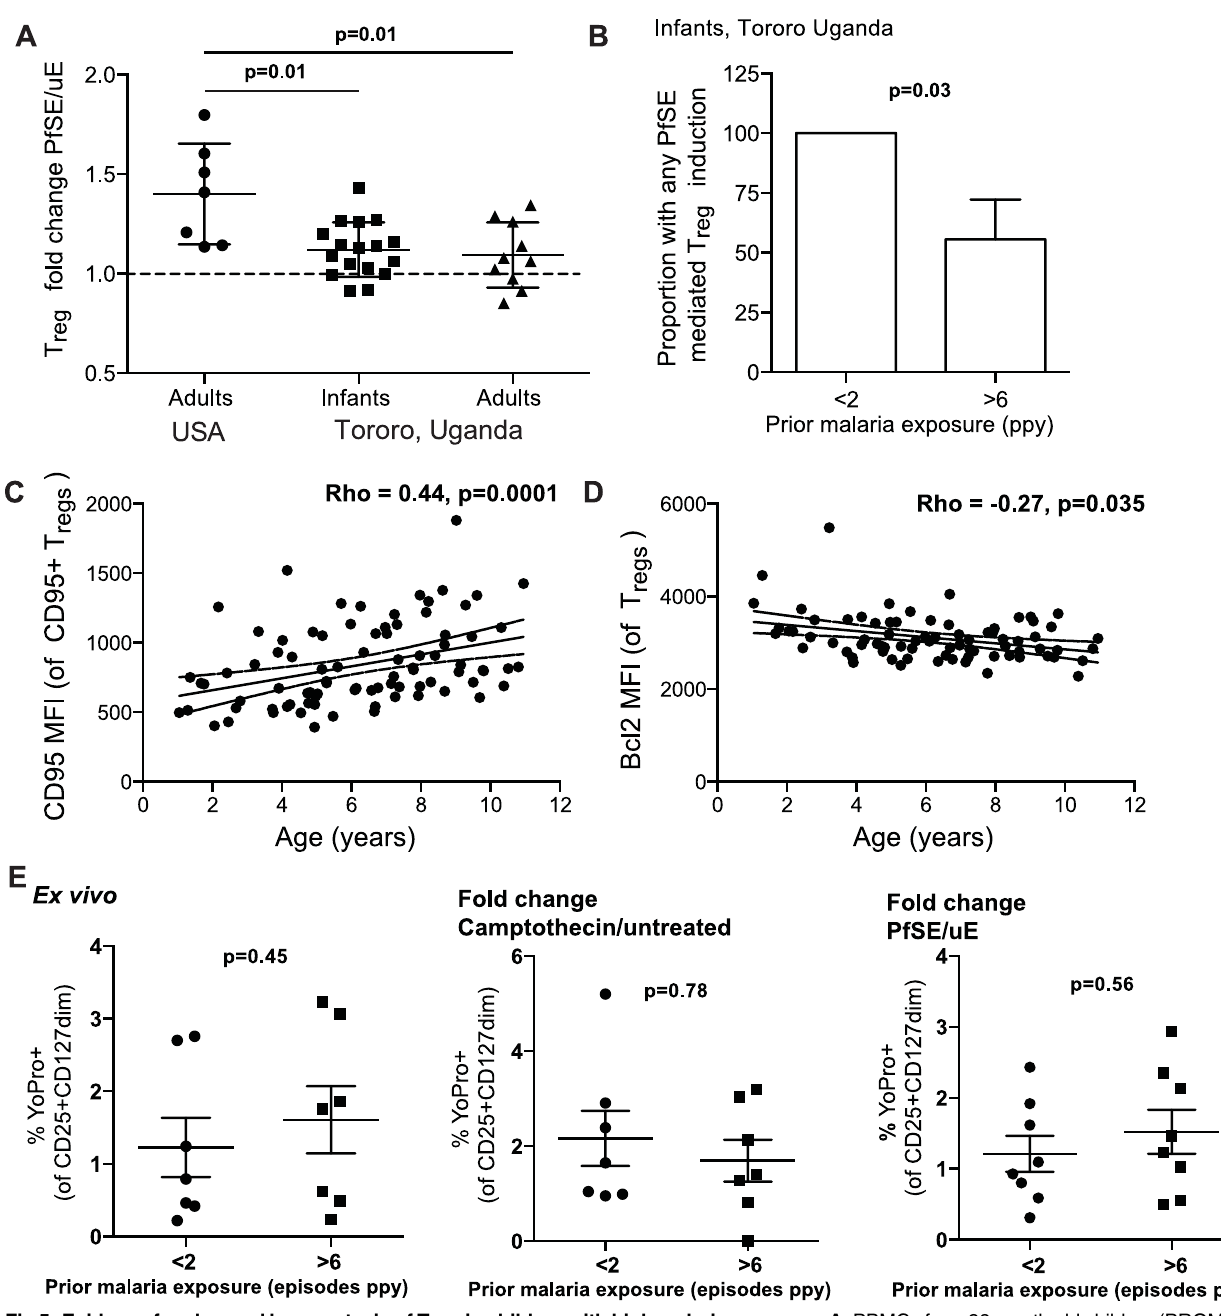
Fig 5. Evidence for changed homeostasis of T regs in children with high malaria exposure. A. PBMCs from 28 month old children (PROMOTE no chemoprevention control arm), malaria-exposed adults (PRISM cohort, Nagongera, Tororo District) and na ï ve adults were incubated for 7 days with protein extract from mature stage P . falciparum infected RBCs (PfSE) or uninfected RBCs (uE). T reg frequencies were enumerated (FoxP3+CD25+CD127 dim ) and induction factor was calculated based on frequency fold change between PfSE and uE stimulated PBMCs. Parasite induction of T regs was reduced in exposed compared to na ï ve individuals. Wilcoxon signed rank test indicated for comparison between na ï ve-adults and exposed infant and adult samples. B. The proportion of children with any T reg induction by PfSE was compared between those with low ( < 2 episodes ppy, n = 10) and high ( > 6 episodes ppy, n = 10) prior malaria incidence. There was a reduced proportion of infants with any T reg induction in those who had high compared to low prior malaria incidence. Chi-square test indicated. C. Pro-apoptotic marker CD95 was measured on T regs in children (PRISM cohort) from the high transmission area (Tororo District). Association between the level of CD95 expression on T regs , as measured by MFI of CD95+ T regs , and age was analyzed. The level of CD95 expression increased with age. D. Pro-survival Bcl2 was measured on T regs in children (PRISM cohort, Nagongera, Tororo) from the high transmission area. Association between the expression of Bcl2 on the T reg population and age was analyzed. The level of Bcl2 expression decreased with age. Spearman ’ s rho and p indicated. E. YoPro staining of T regs from 28 month old children (PROMOTE, no chemoprevention control arm, with low ( < 2 episodes ppy) and high ( > 6